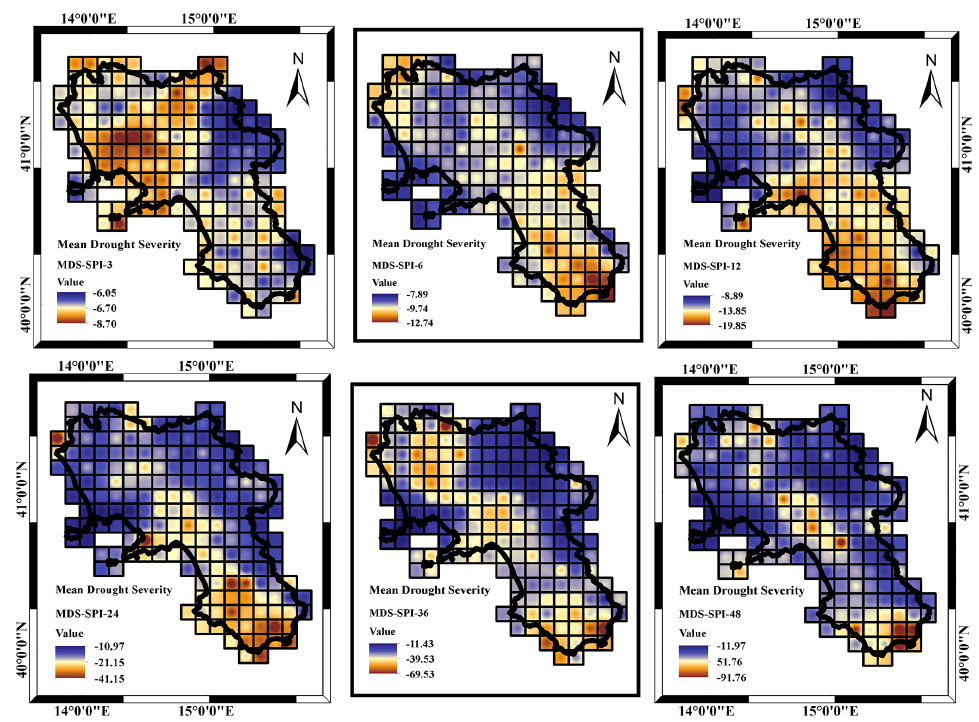
Figure 9. MDS (mean drought severity) for the different accumulation periods considered (SPI ≤ −